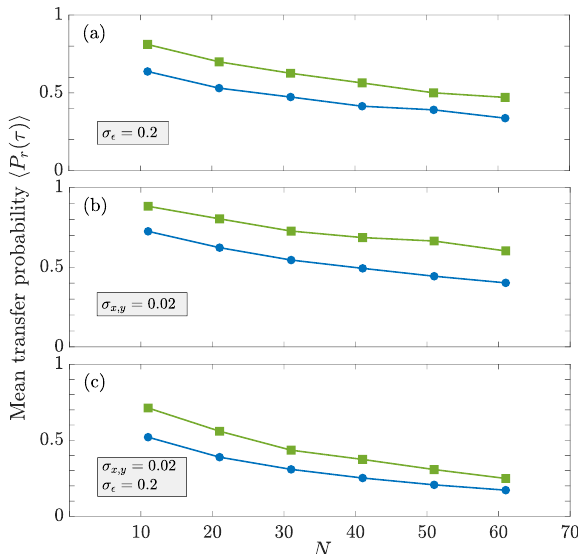
〉 vs chain length N , obtained upon Figure 7: Mean excitation transfer probability 〈 P r averaging over 1000 independent realizations of disordered chains with long-range exchange interactions, for the stimulated adiabatic transfer (green solid lines with filled squares), compared to the static transfer of Fig. 6 (blue solid lines with filled circles), for (a) energy (diagonal) disorder with standard deviations σ ε , (b) position (off-diagonal) disorder with standard deviation σ , and (c) combination of energy x , y and position disorder. We use the time-dependent couplings of Eq. (10) for the sender = − 0.22 J , with the transfer duration τ of and receiver spins having energies ε s , r Fig.